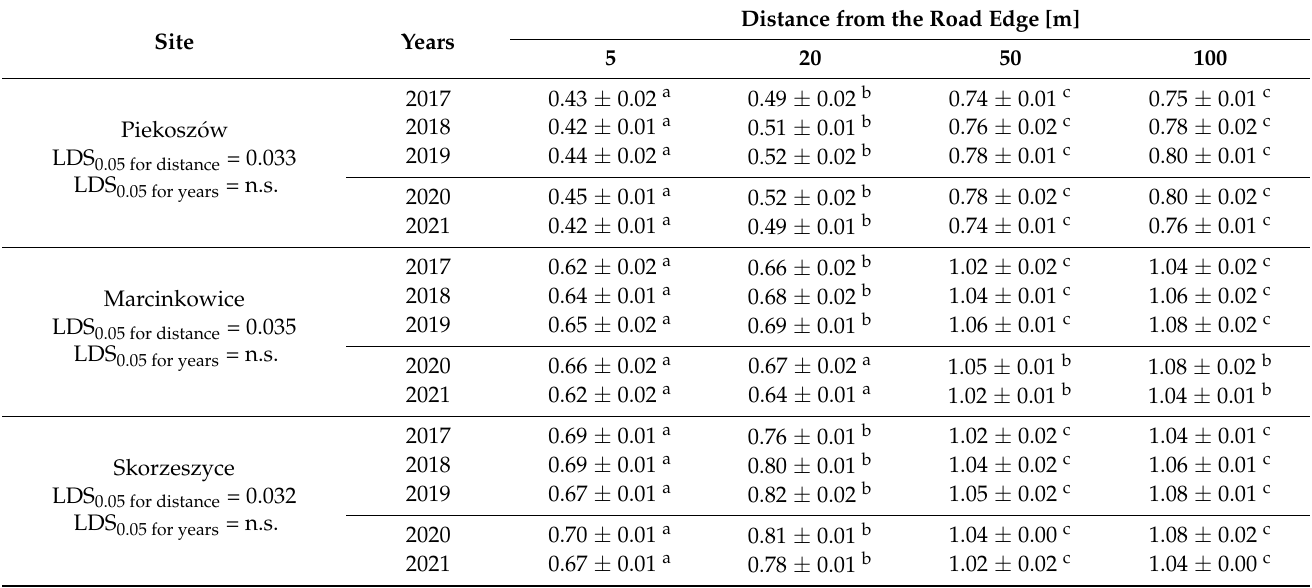
Table 5. Total nitrogen content (TN in g kg − 1 ) in soils before the COVID-19 pandemic (2017–2019) [28] and during the pandemic